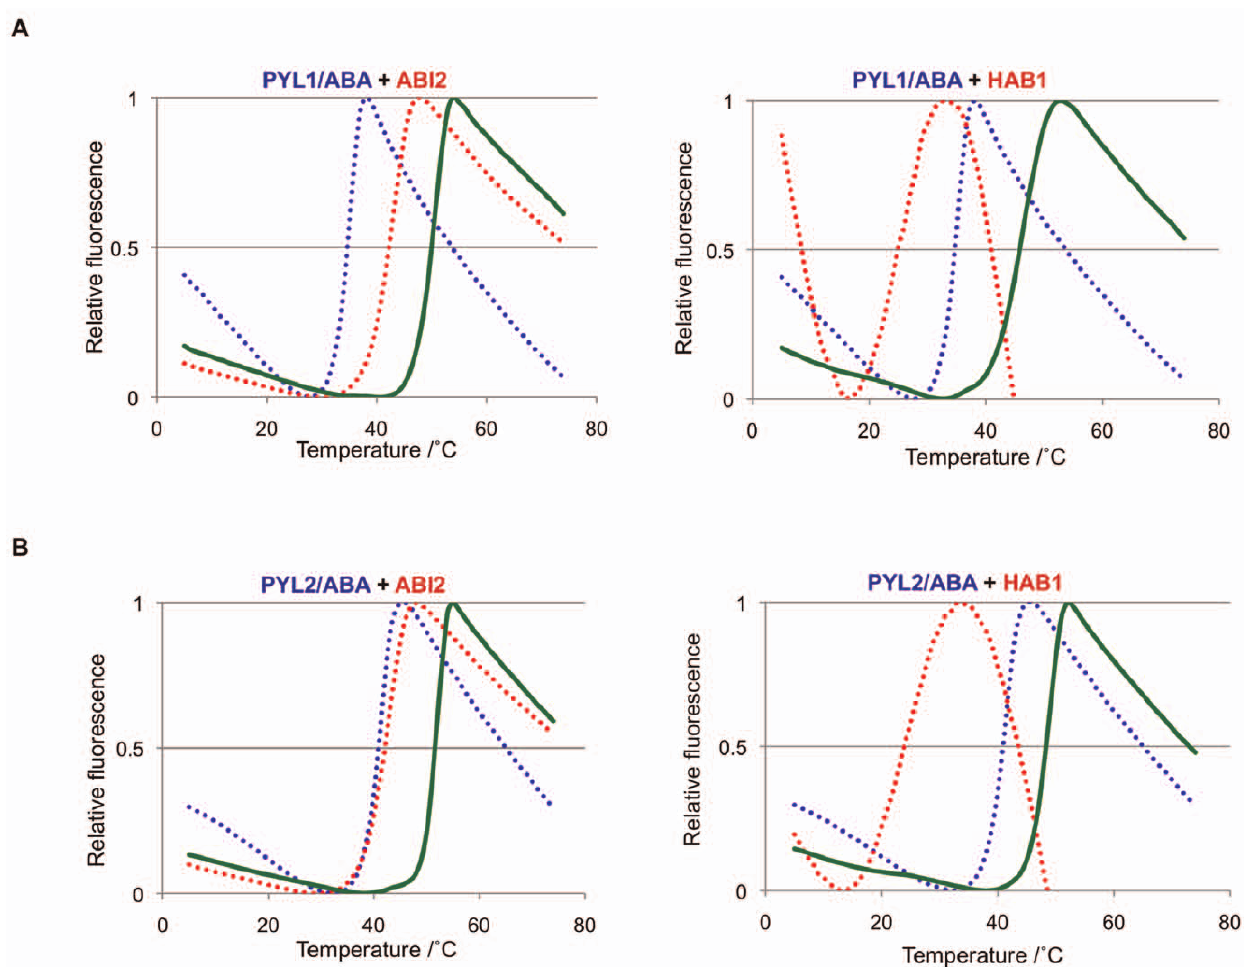
Figure 5. Formation of ternary receptor/ligand-phosphatase complexes. Both the PYL1 and PYL2 receptors were able to interact with the HAB1 and ABI2 phosphatases to form complexes in the presence of ( + )-ABA. Melt curves of ligand-bound receptors (dashed blue lines), PP2Cs (dashed red lines), and receptor-PP2C complexes (solid green lines). Receptors and PP2C were at 10 m M, ( + )-ABA at 500 m M. ( A ) PYL1 with ABI2 (left) and HAB1 (right). ( B ) PYL2 with ABI2 (left) and HAB1 (right).